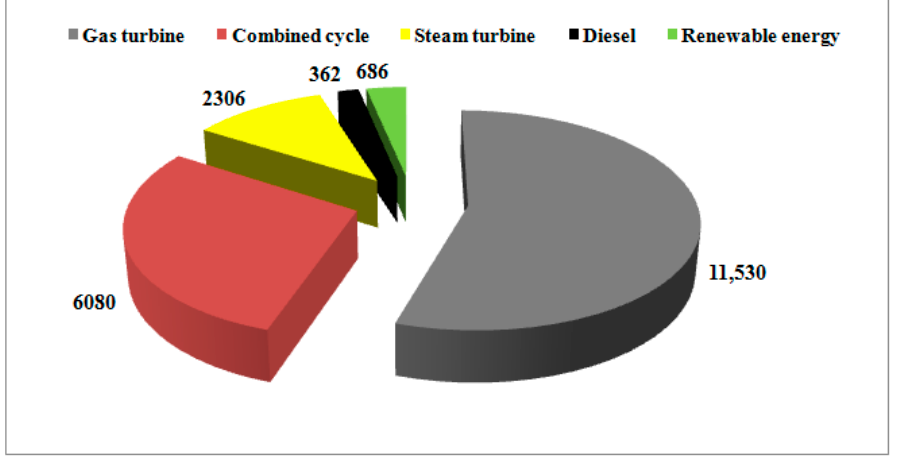
Figure 3. The total installed capacity breakdown of Algeria until 2018.